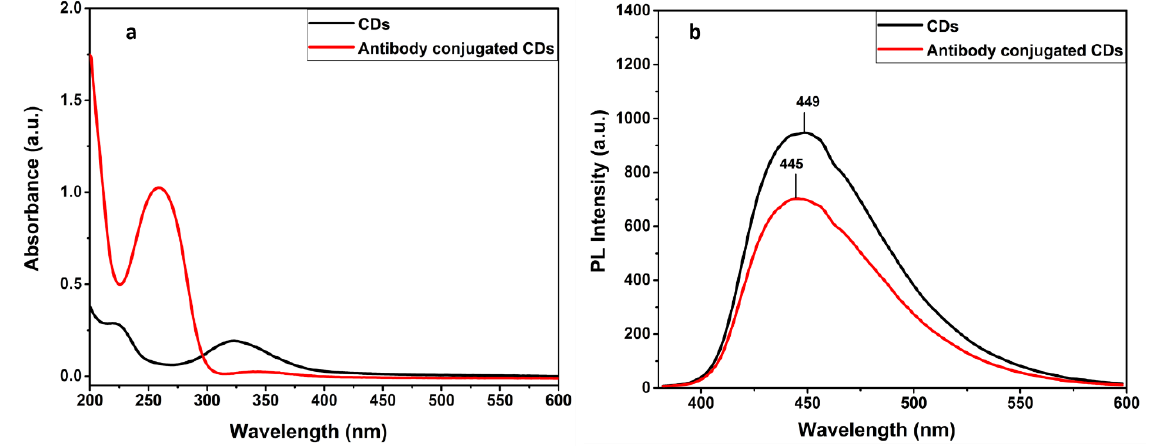
Figure 5. Absorbance ( a ) and PL emission spectra of CDs and antibody conjugated CDs ( b ). Parametric Performance Optimization and Quenching Efficiency